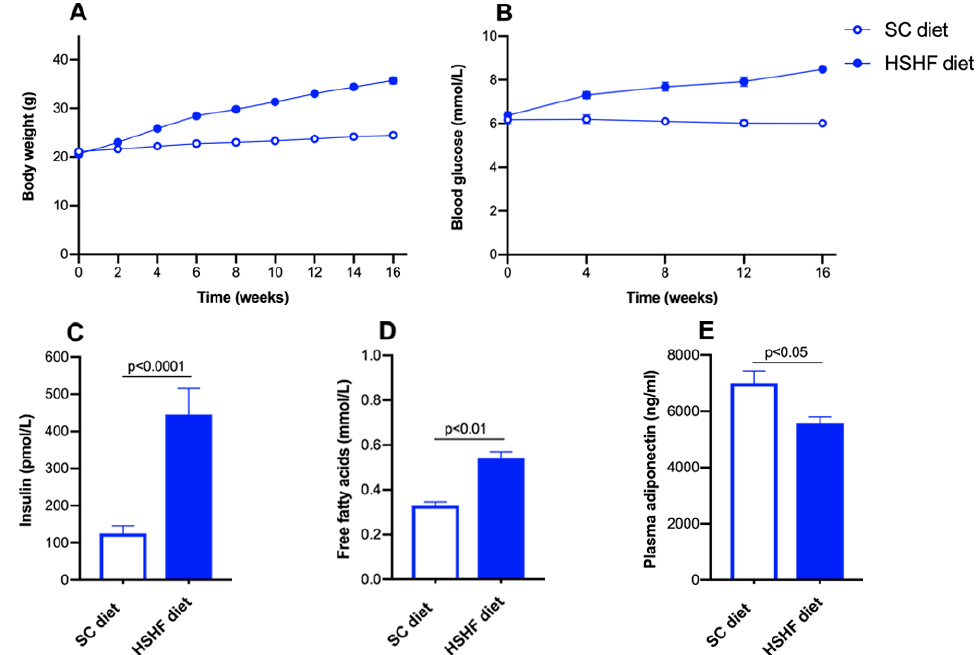
Figure 1. Time course of body weight ( A ) and blood glucose levels ( B ) in C57BL/6N mice fed the standard chow (SC) diet or the high-sugar/high-fat (HSHF) diet. Plasma insulin ( C ), free fatty acids ( D ), and adiponectin ( E ) levels at 16 weeks after the start of the diet. Week 0 in panels A and B corresponds to the age of 12 weeks, the start of the HSHF diet. All data represent mean ± SEM. ( n = 15 for SC diet; n = 20 for HSHF diet).